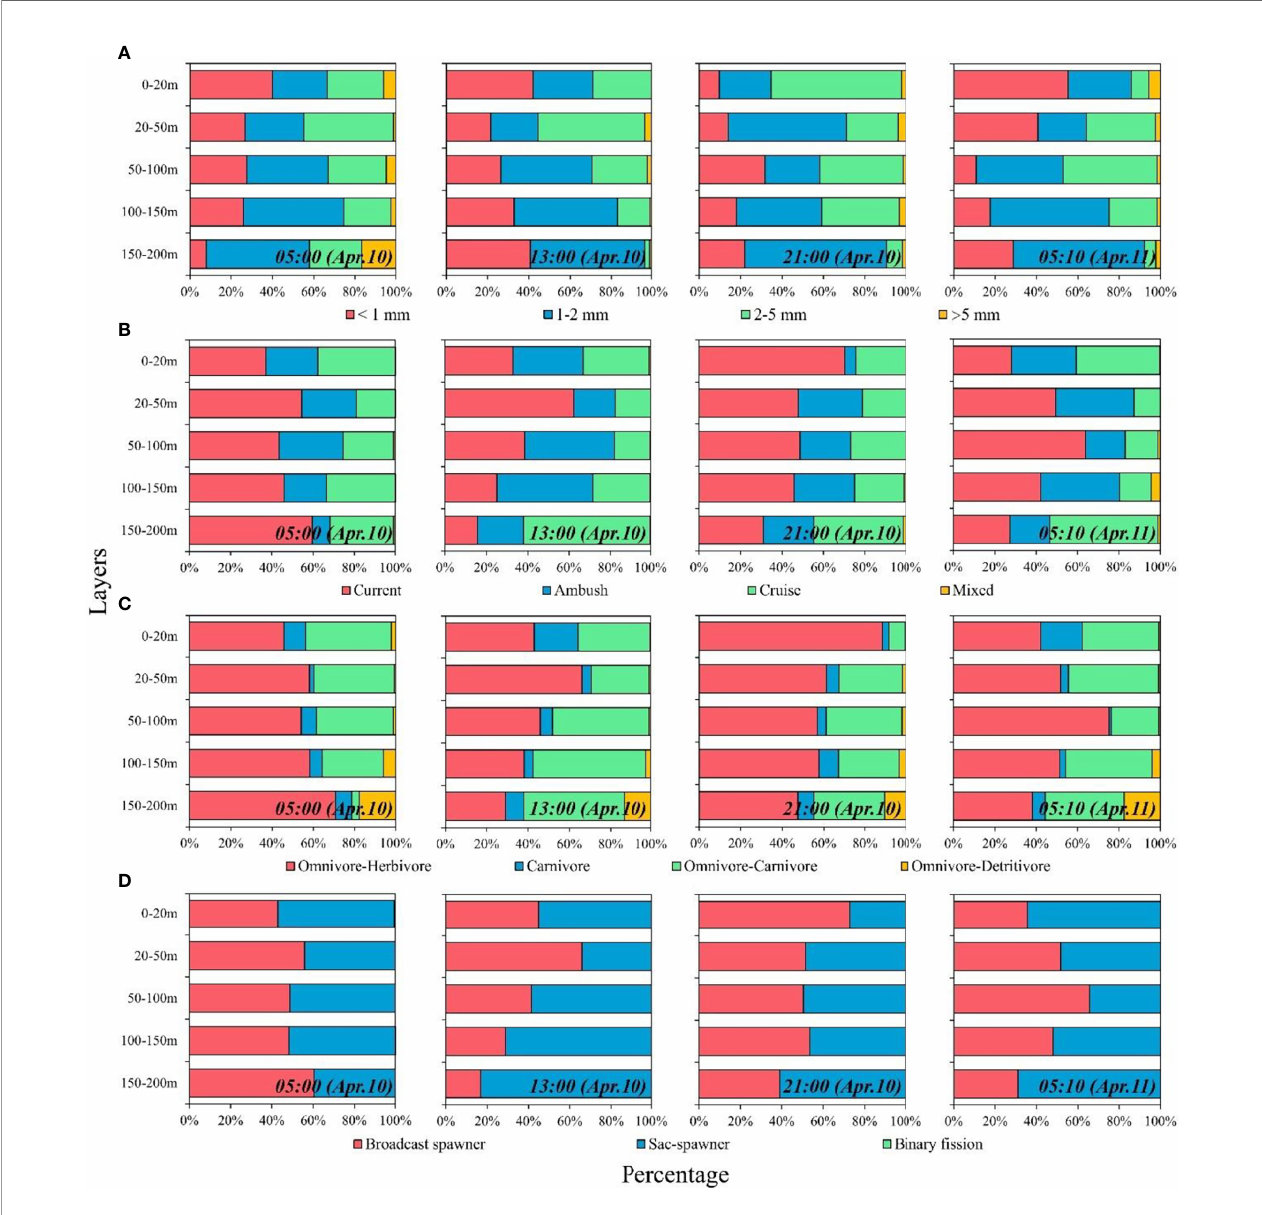
FIGURE 4 | Diel vertical distribution of each functional trait. (A) Body length; (B) feeding type; (C) trophic group; and (D) reproductive